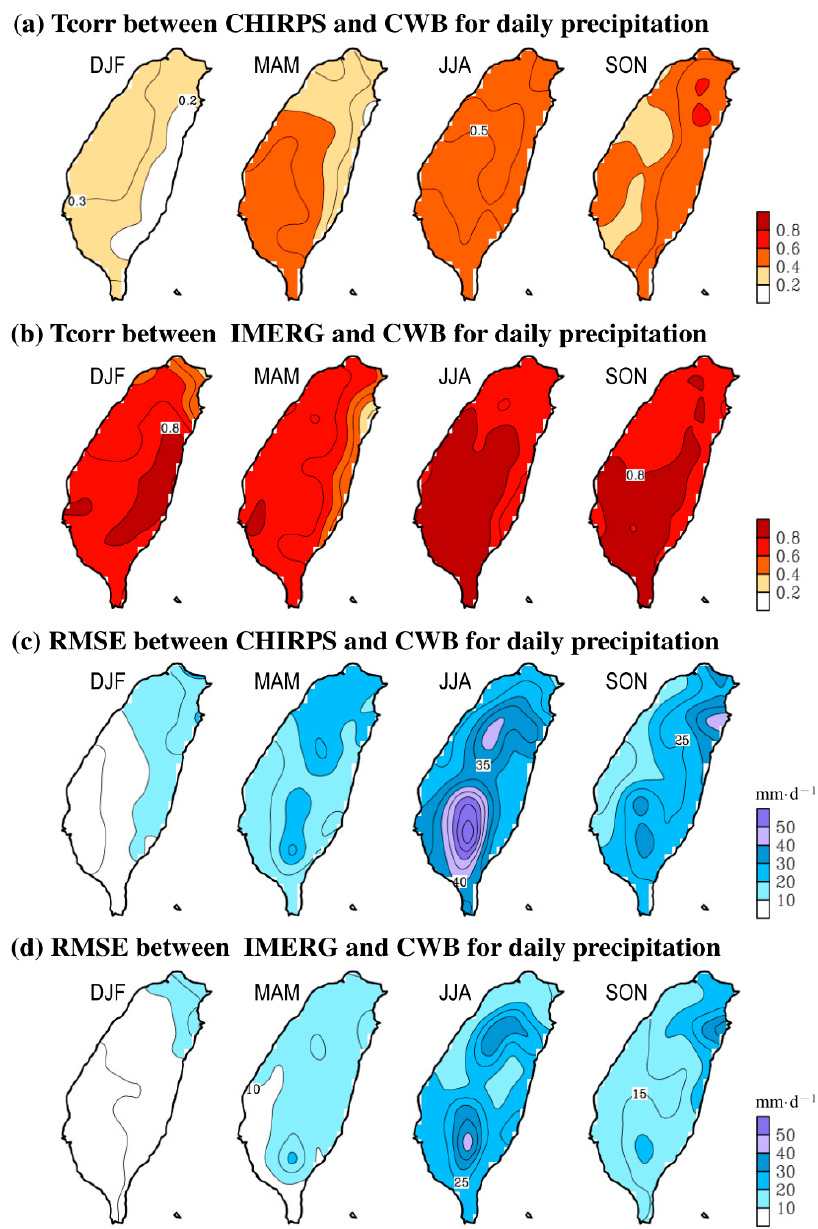
Figure 9. Similar to Figure 5, but for grid-to-grid comparison of daily precipitation between CWB and selected SPPs estimated for winter (DJF), spring (MAM), summer (JJA), and autumn (SON) seasons of 2001–2019: ( a ) Tcorr between CWB and CHIRPS, ( b ) Tcorr between CWB and IMERG, ( c ) RMSE between CWB and CHIRPS, and ( d ) RMSE between CWB and IMERG.